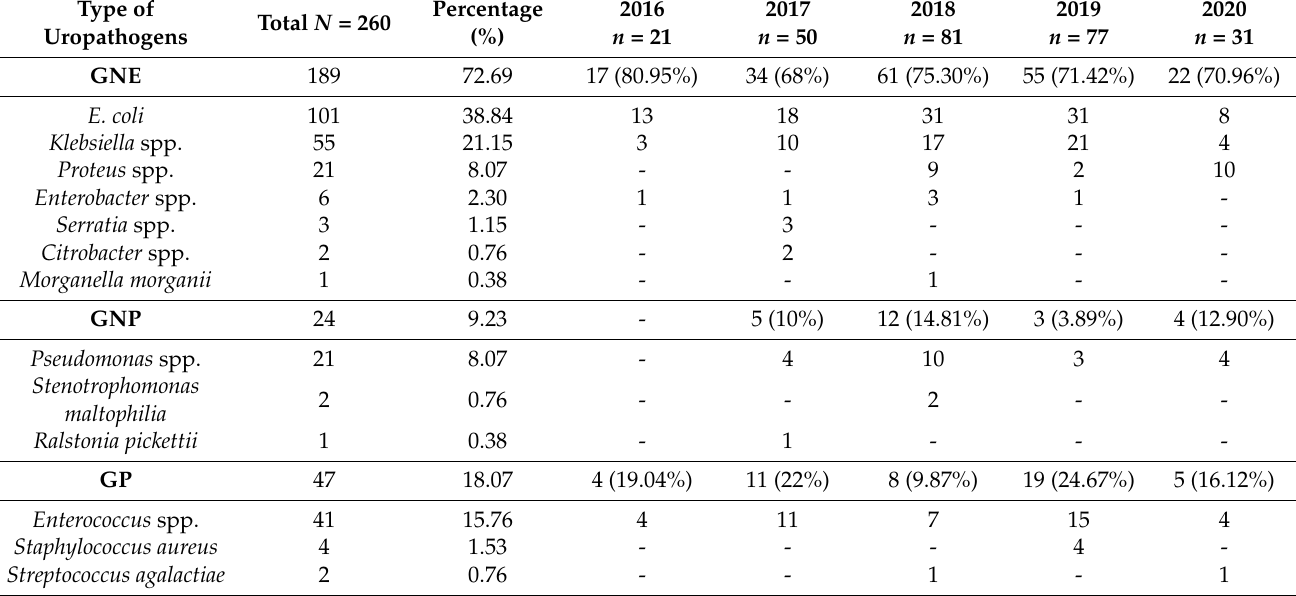
Table 2. Annual frequency of uropathogens causing UTI in children with CAKUT, between 2016–2020. Type of